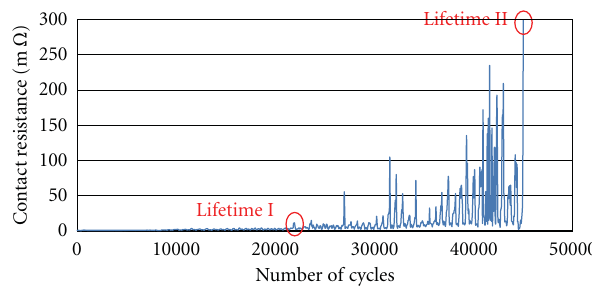
Figure 3: Increases in contact resistance due to fretting corrosion